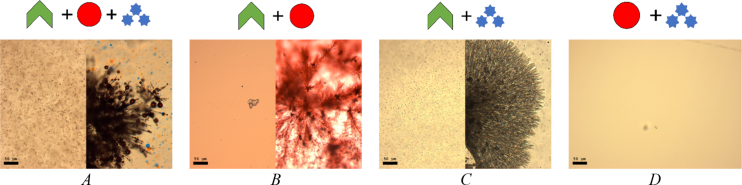
System response in the absence of surfactant micelles (A), micelles and NaCl (B), micelles and FeSO4 (C), micelles and BPhen (D). Scale bar is 50 μm.